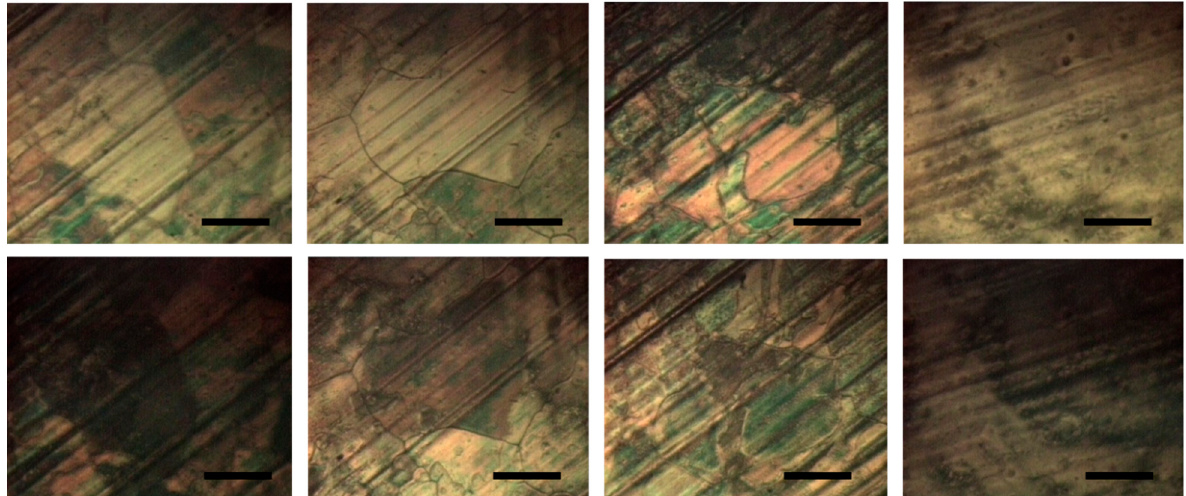
Figure 8. Four vertical pairs of microphotographs of E7-coated graphene (top—bright state; bottom—dark state achieved after rotation at 45°). The images depict: graphene grains on electropolished Cu foil (left two pairs) and on nonprocessed Cu foil (right two pairs). The scale bars represent 100 μ m.